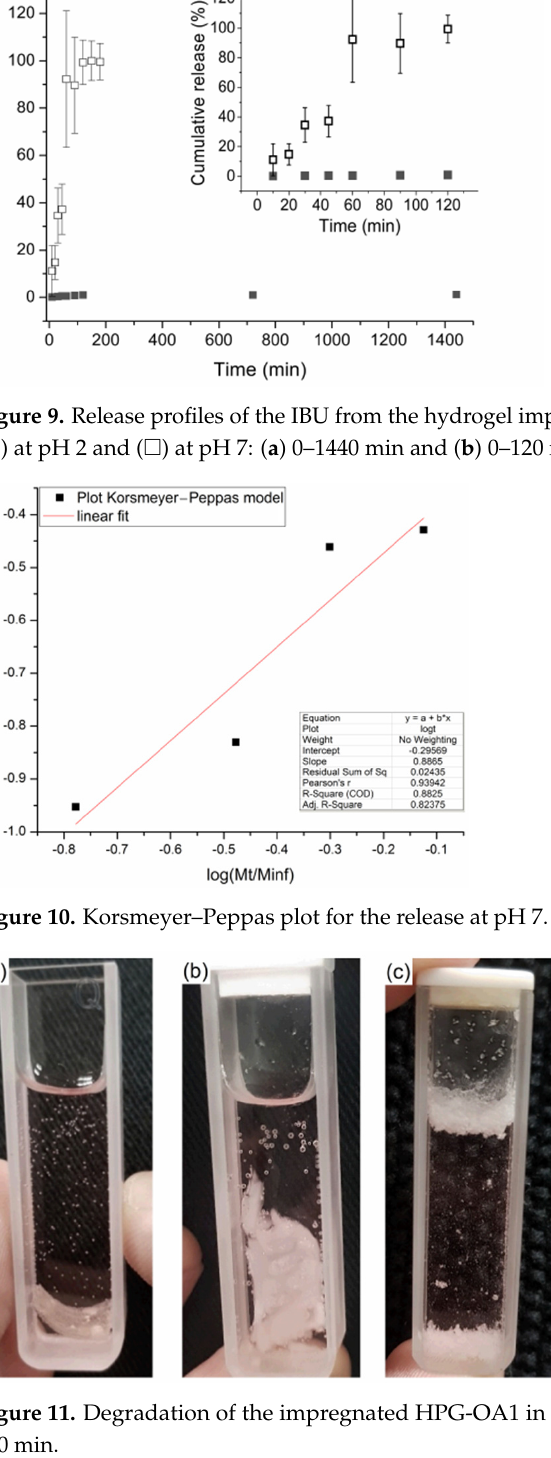
Figure 11. Degradation of the impregnated HPG-OA1 in pH 7 ( a ) t = 0 min, ( b ) t = 120 min, ( c ) t = 180 min.